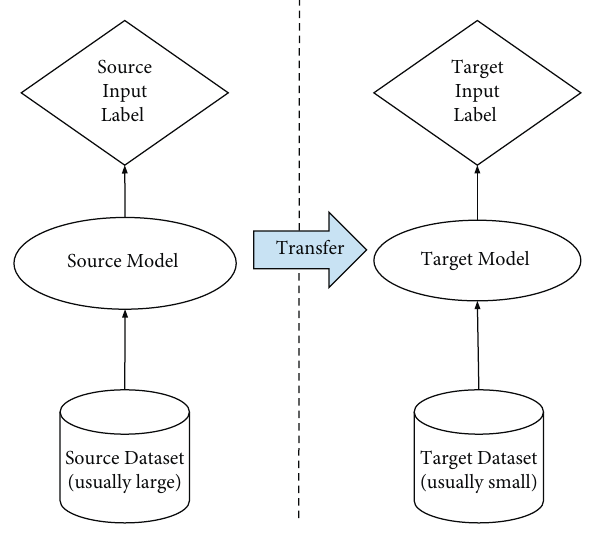
Figure 6: Transfer learning